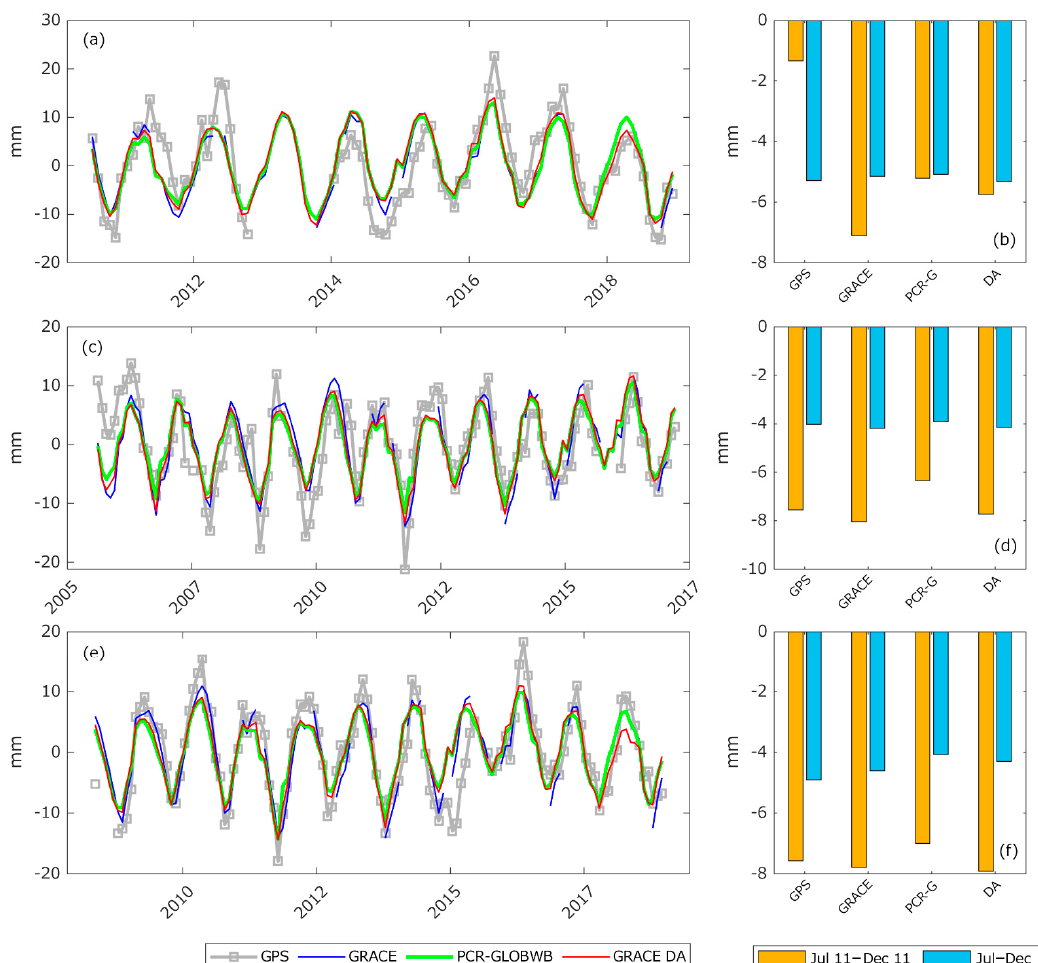
Figure 8. (Left column) The ∆ r estimates from the GPS, GRACE, PCR-GLOBWB, and GRACE DA at the three evaluation sites: S1 ( a ), S2 ( c ), and S3 ( e ). Note that the evaluation period (horizontal axis) is different for different evaluated sites regarding GPS measurement availability. In ( c ), the blue ovals demonstrate the periods where the GPS ∆ r is more significant than the GRACE or model estimates. (Right column) The average land subsidence (negative ∆ r) computed during the great flood of 2011, July–December 2011 (orange) estimated from the GPS, GRACE, PCR-GLOBWB (PCR-G), and GRACE DA (DA) at three evaluation sites: S1 ( b ), S2 ( d ), and S3 ( f ). For comparison, the average land subsidence computed from all July–December (2002–2018) values is also shown (blue).